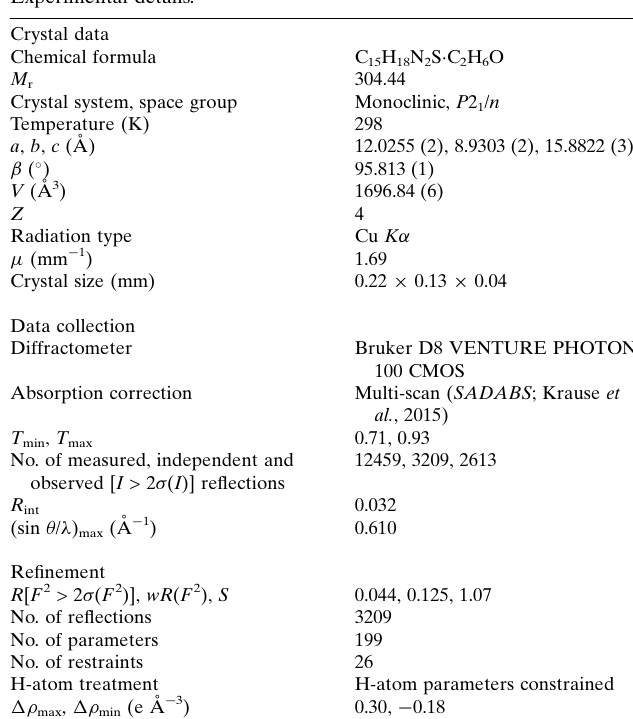
Table 2 Experimental